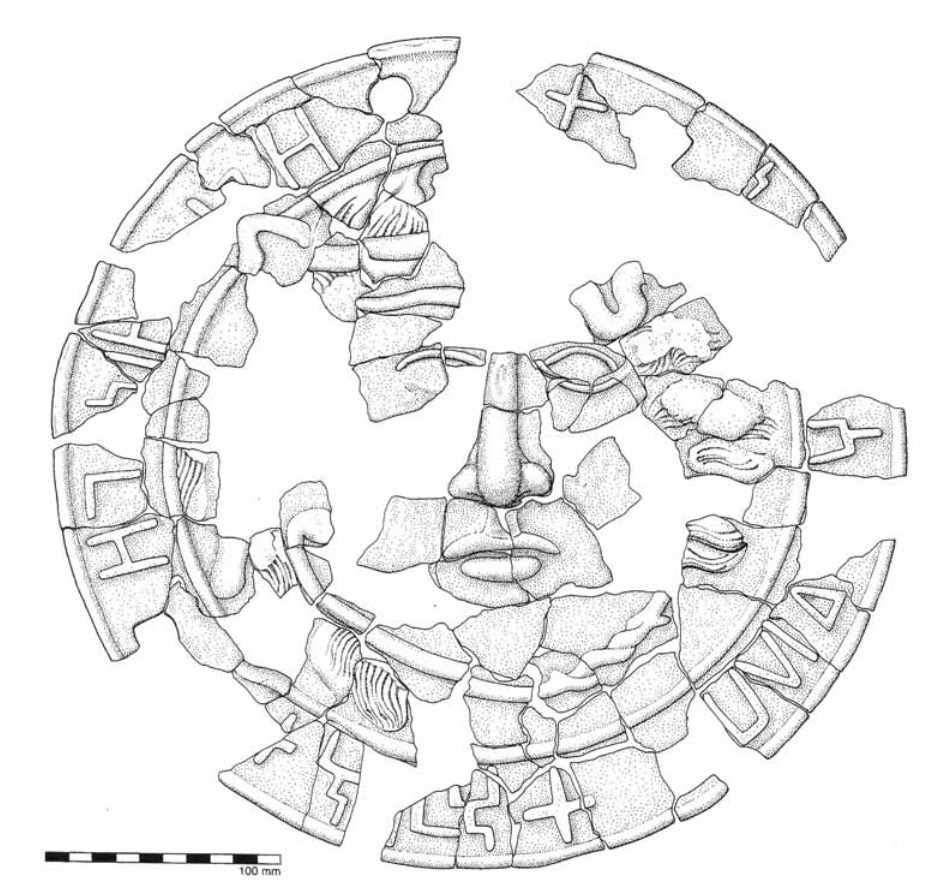
Fig. 1: Cast brass disc formerly attached to the apex of a monolithic stela marking one of the royal tombs at Aksum (3rd-4th century